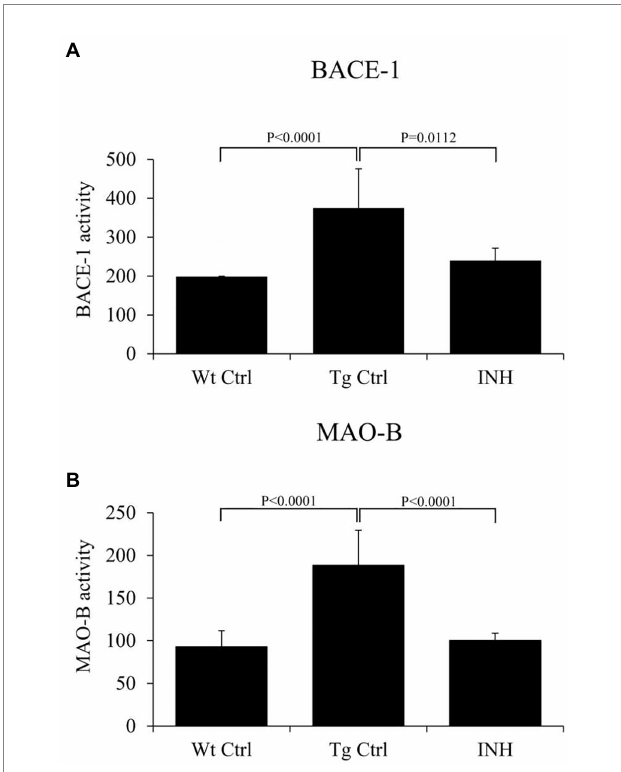
FIGURE 4 (A,B) INH inhibited the enzyme activities of BACE1 and Mao-b in the hippocampus of APP/PS1 mice.